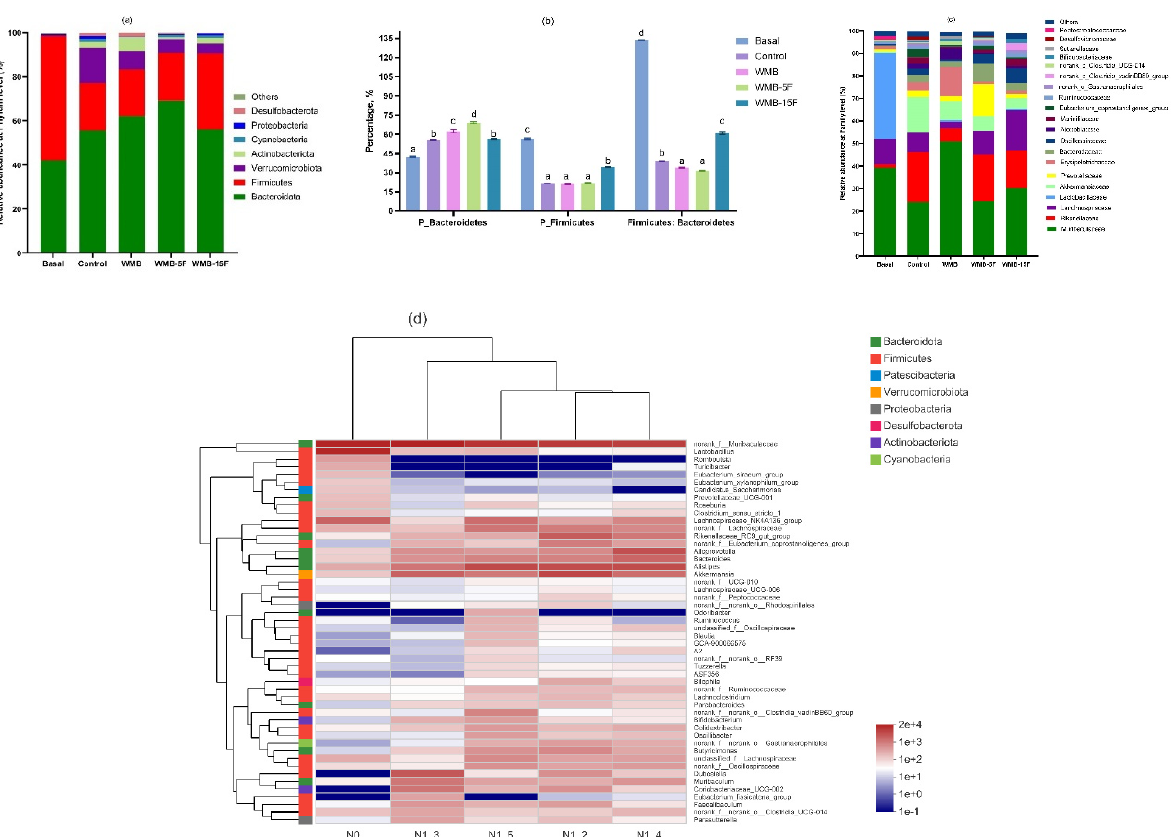
Figure 1. The relative abundance of gut microbiota at the phylum level ( a ) and family level ( b ) in mice groups at 0 (basal) and after 21 days fed on customized bread diets. The relative abundance of Firmicutes , Bacteroidetes , and Firmicutes : Bacteroidetes ratio ( c ). Heat map cluster analysis of the effect of customized bread diets on mice groups at 0 (basal, N0) and after 21 days fed on control (N1_2), WMB (N1_3), WMB-5F (N1_4), and WMB-15F (N1_5) ( d ). Different lower-case letters in the same column and upper-case letter in same row for specific treatment indicated significant difference ( p <